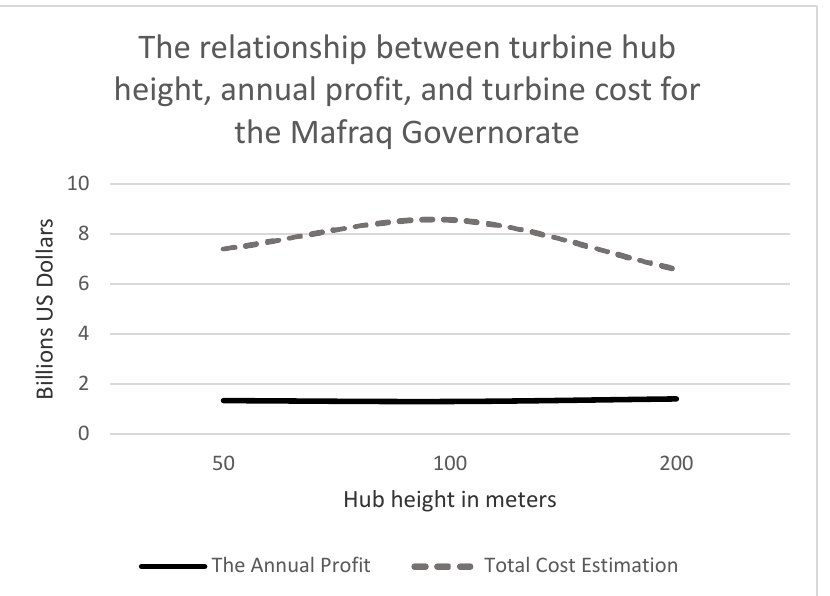
Figure 6. The relationship between turbine hub height, annual profit (solid trend line), and turbine cost (dashed trend line) for the Mafraq Governorate.